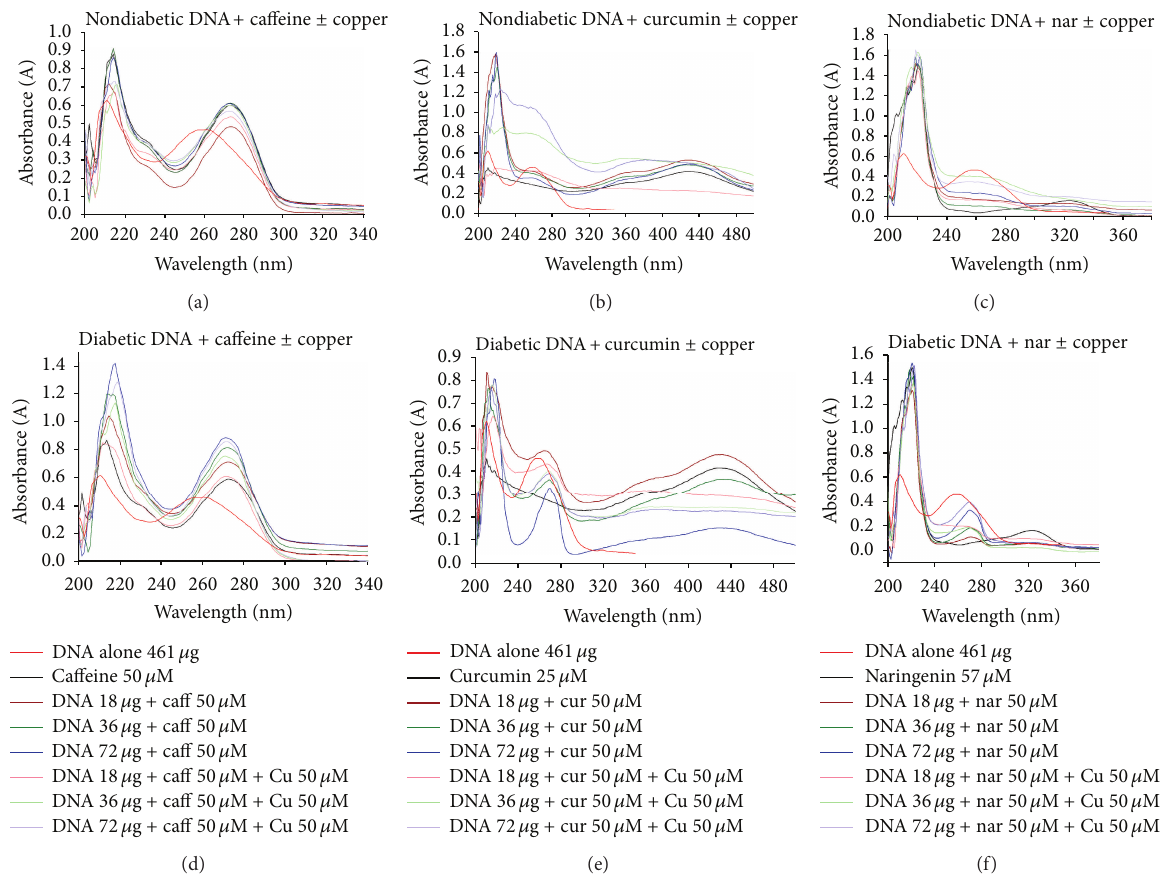
Figure 2: Spectra of caffeine, curcumin, and naringenin with DNA from nondiabetic ((a), (b), (c)) and diabetic subject ((d), (e), (f)) in the presence and absence of